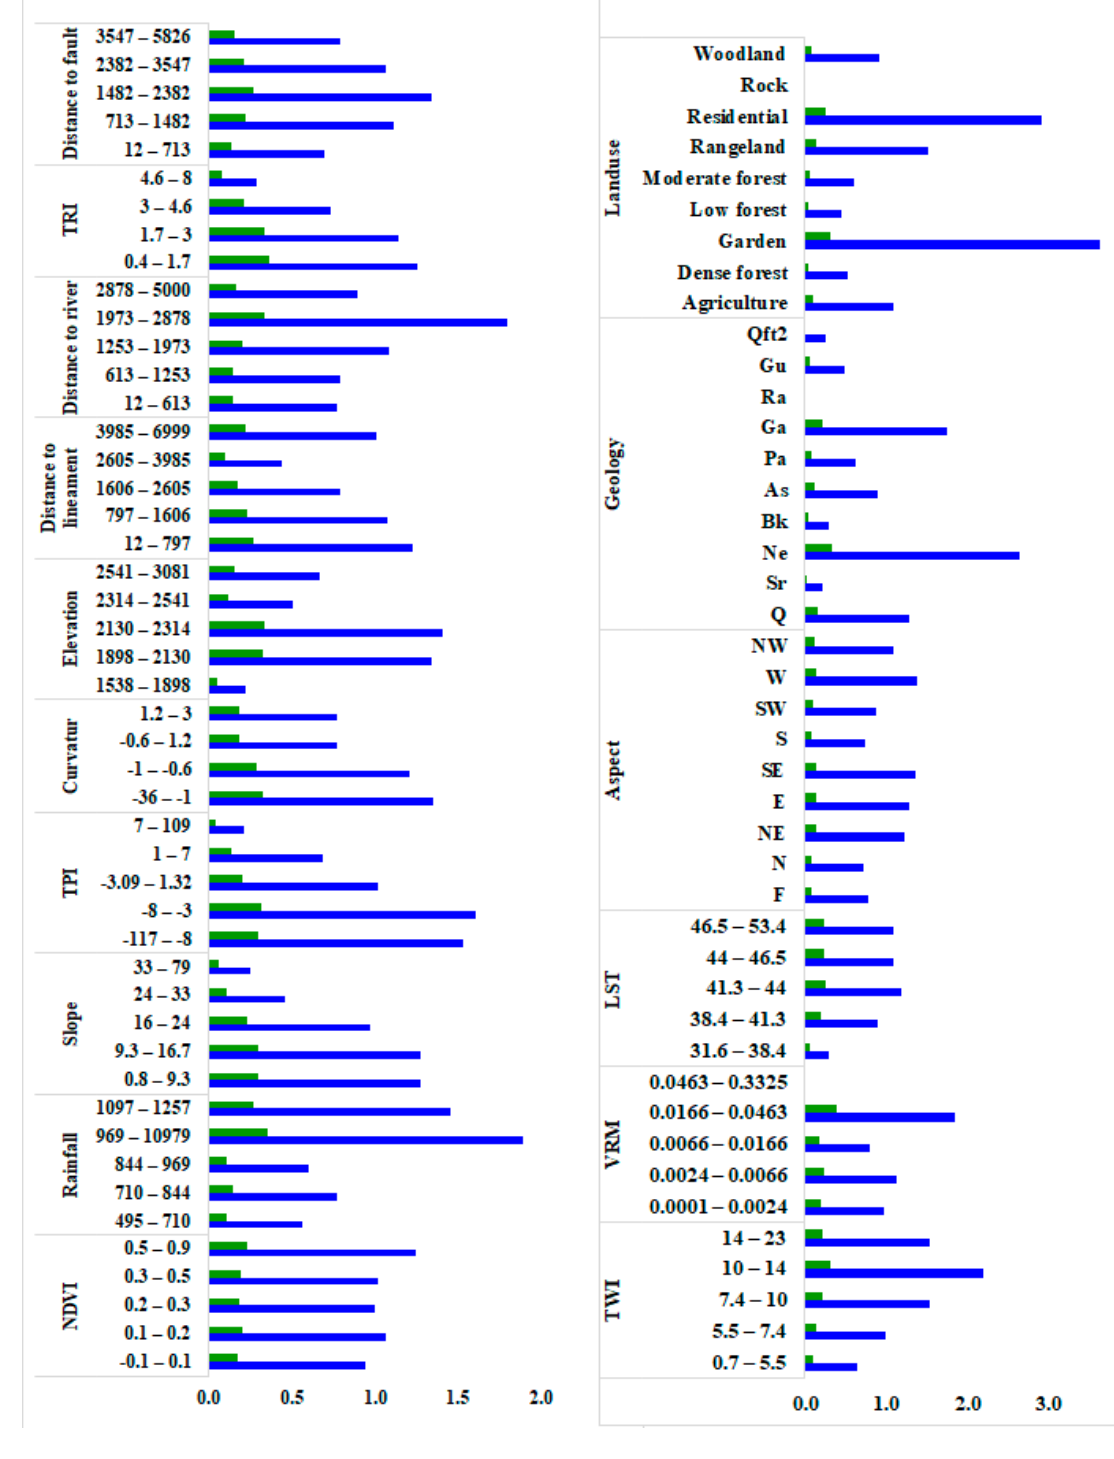
Figure 3. FR values for the FIGKR classes.